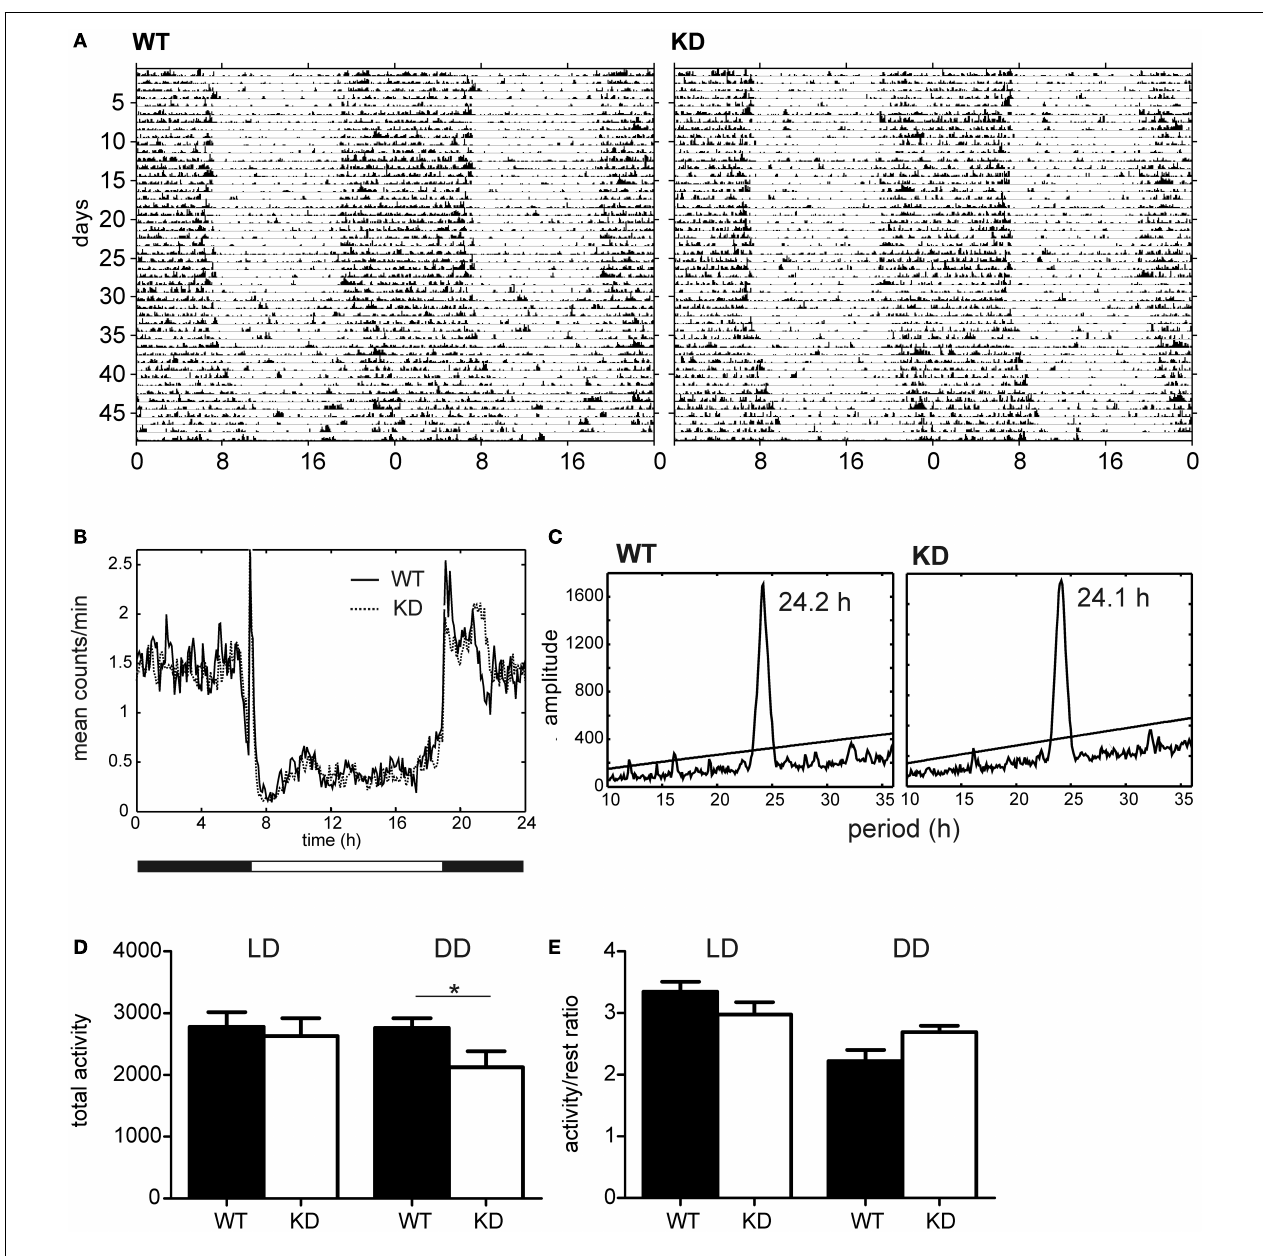
eightWT (solid line) and six KD (dashed line) rats kept under LD12:12. (C) Cumulative periodogram of eightWT (left) and six KD (right) rats kept under DD. (D) Total locomotor activity of eightWT (black) and six KD (white) rats kept under LD12:12 (left) or under DD (right). (E) Activity/rest ratio of eightWT (black) and six KD (white) rats kept under LD12:12 (left) or under DD (right).